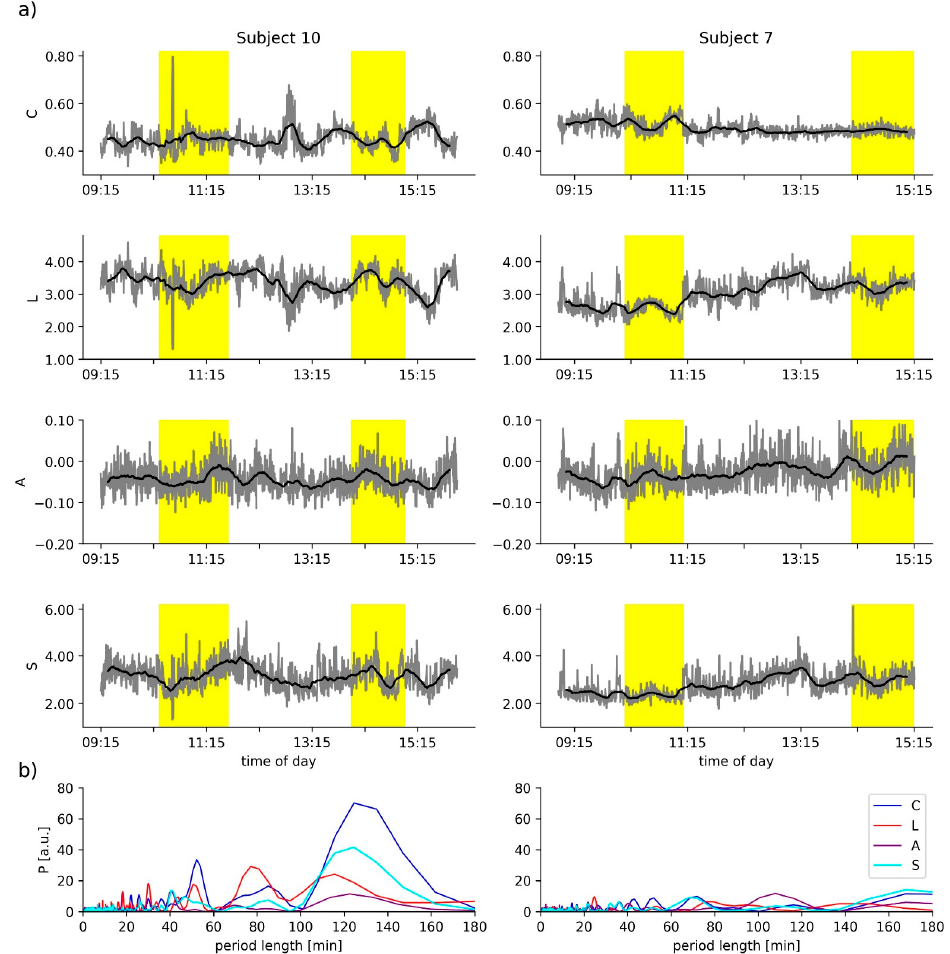
Figure 2. ( a ) Exemplary time courses (grey lines) of average clustering coefficient C , average shortest path length L , assortativity A , and synchronisability S of two subjects. Smoothed time courses (moving average over 17 min) are shown as black lines. Yellow-shaded areas mark the two 1 h stimulation phases. ( b ) Power spectral density estimates P of the respective time courses.